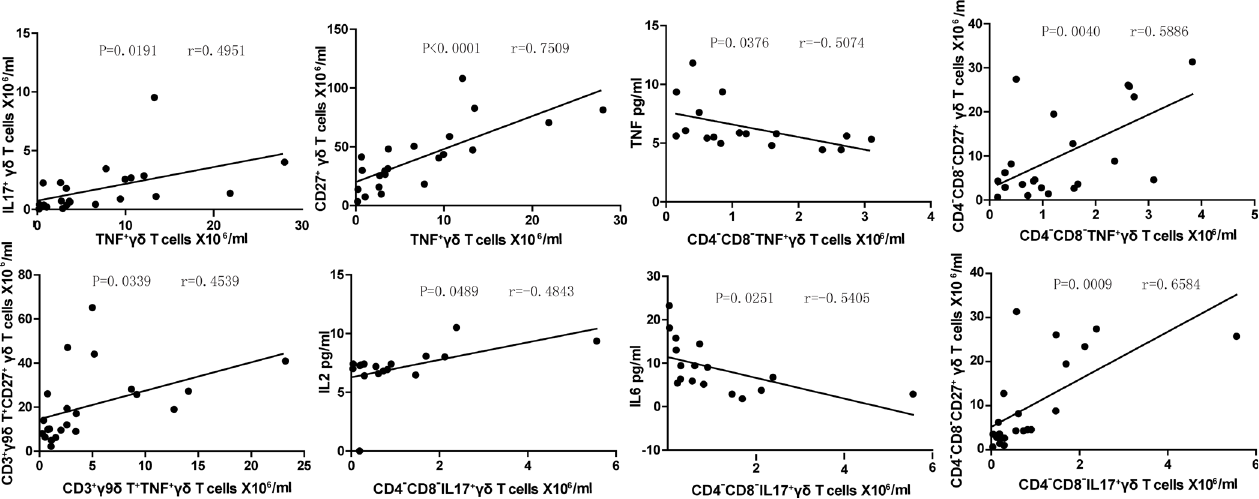
Fig 6. Correlations between the different subsets of γδ T cells. The levels of the numbers of different subsets of γδ T cell were correlated in SLE patients. Apart from those shown no statically significant correlations were detected.